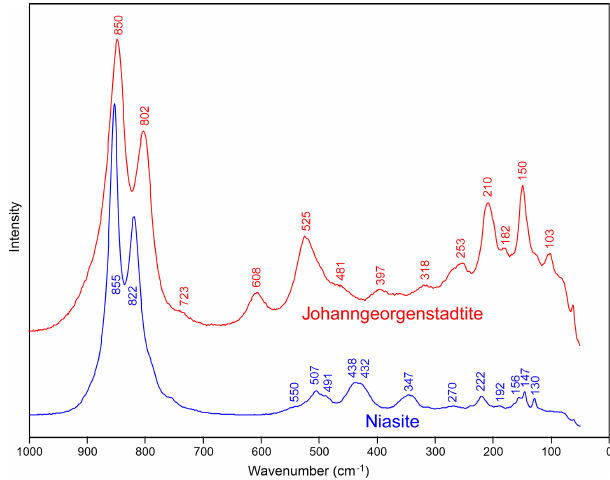
Figure 4. Johanngeorgenstadtite (pink orange) with aerugite (green) and xanthiosite (yellow) on holotype specimen (AMNH 17956); FOV 0.56mm across.